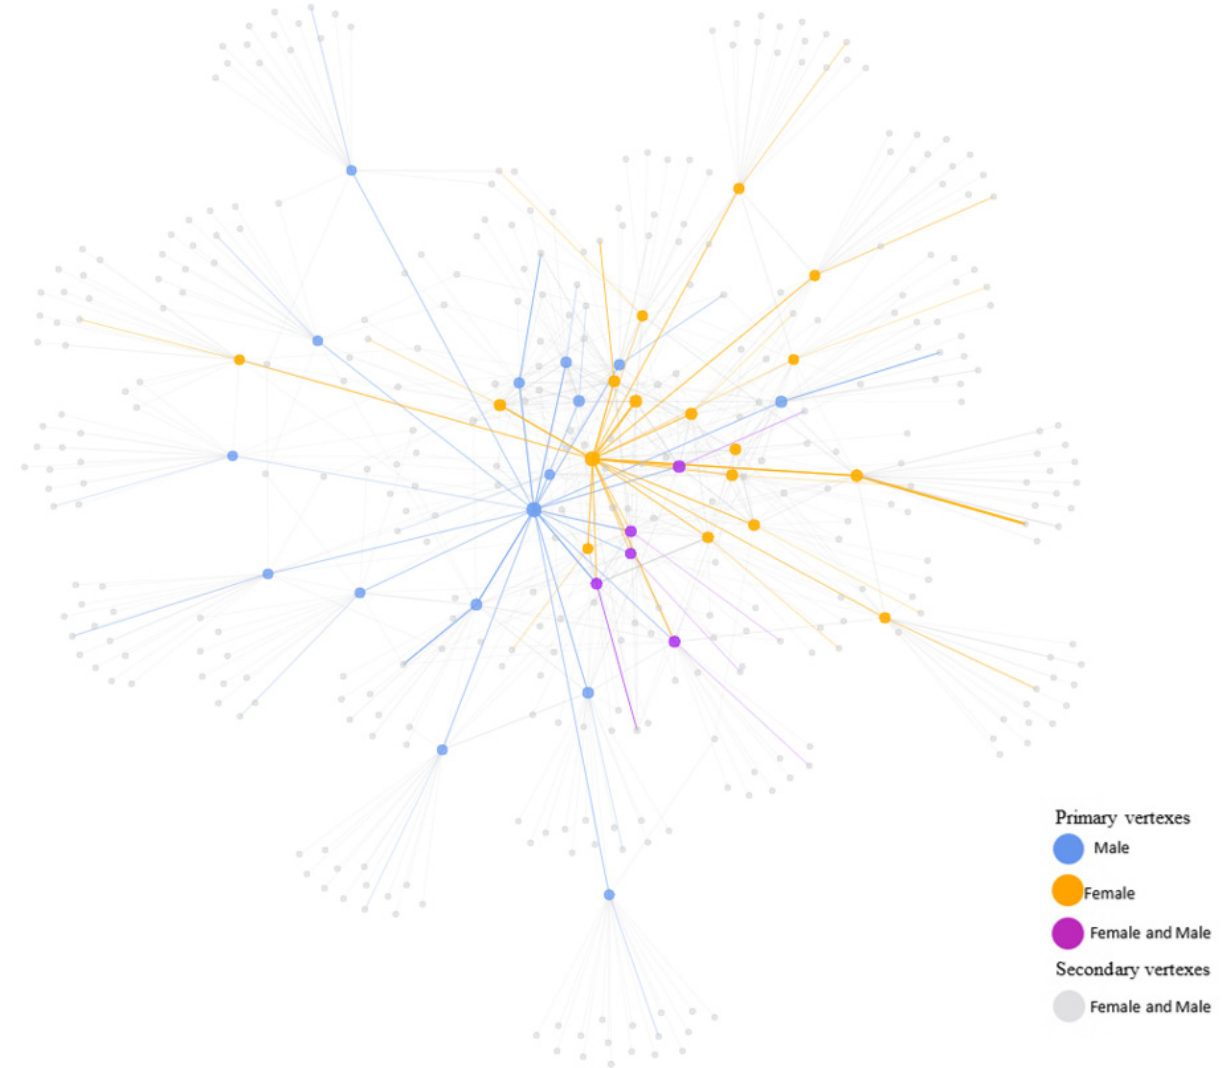
Figure 2. A representation of the ten most significant paths in the network for each gender among the whole network. Paths were selected after filtering out paths that crossed through the other gen- der vertex.